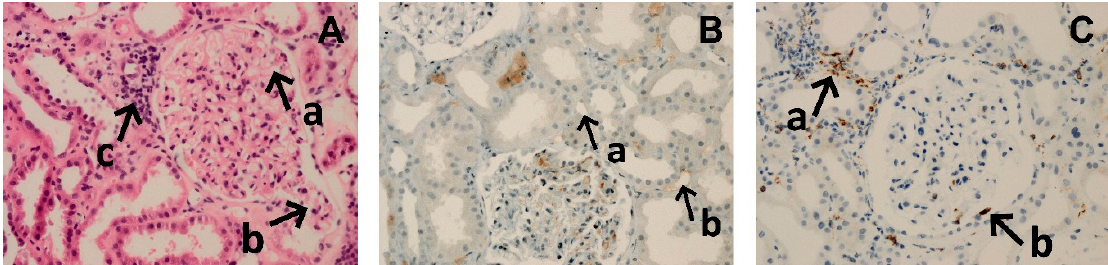
Figure 2. Microphotograph presenting histological findings after bortezomib-based therapy of acute antibody-mediated rejection. ( A ) Hematoxylin and eosin, magnification 200 × . Patent capillary lamina without signs of microangiopathy or glomerulitis (a). Prolapse of capillary tuft into the lumen of proximal tubule (b). Small foci of interstitial inflammatory infiltrates (c). ( B ) Negative (a) and nonspecific (b) peritubular capillary C4d staining. Magnification 200 × . ( C ) Small interstitial foci of CD68 + cells (a). Single CD68 + cells within glomeruli (b). Magnification 100 × .